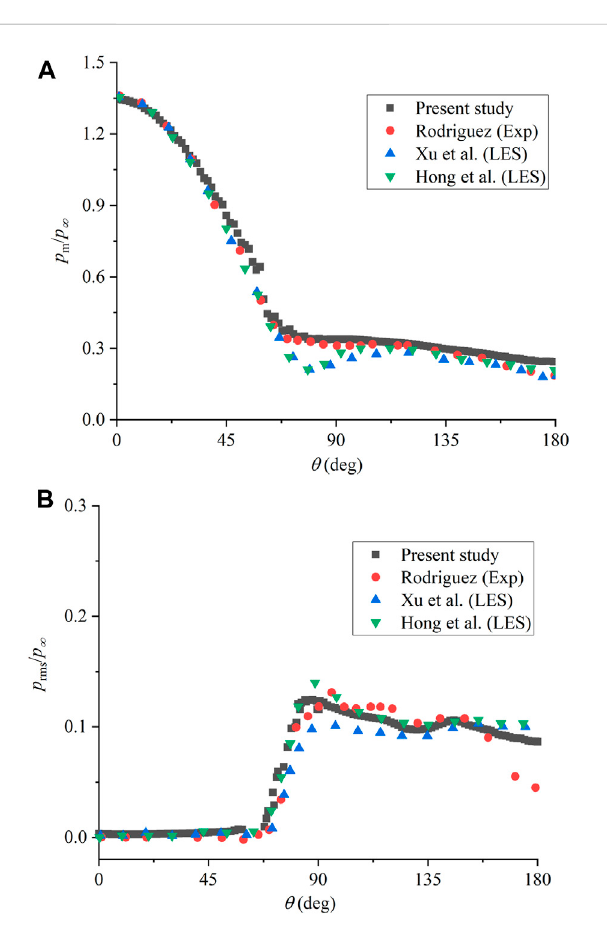
FIGURE 4 Comparison of the calculated results with experimental data: (A) time-averaged wall pressure; (B) RMS of pressure fl